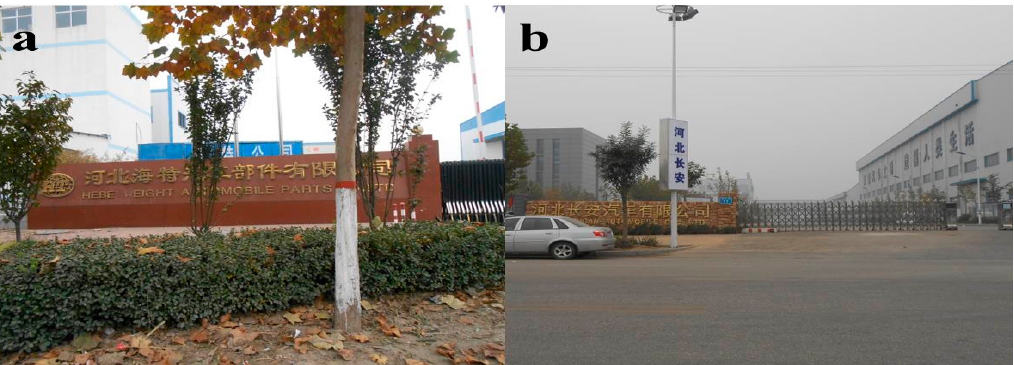
Figure 4. Industrial parks of Dingzhou in Nancheng Town: ( a ) Hebei Height Auto Parts Co., Ltd.; ( b ) Hebei Changan Automobile Co., Ltd.